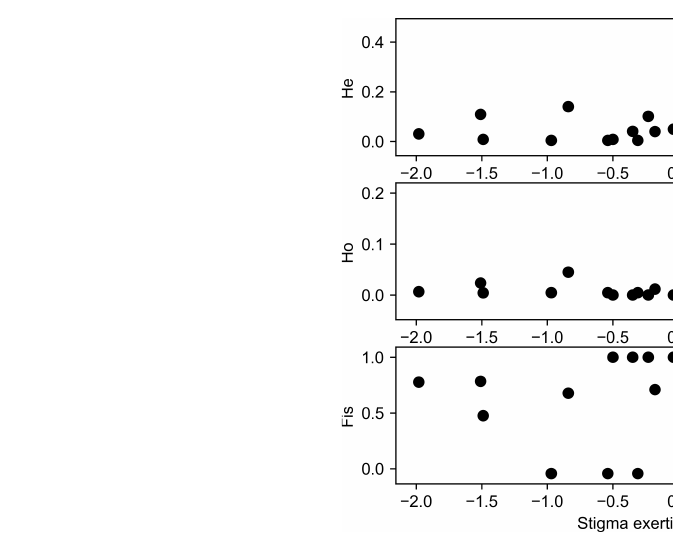
FIGURE 4 Association of the stigma exertion with molecular diversity